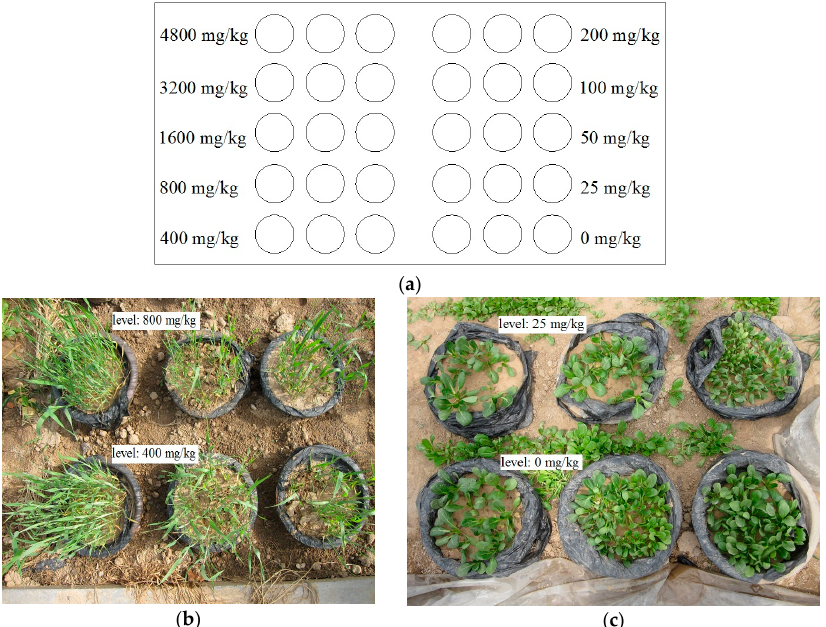
Figure 1. The experimental scene of some samples: ( a ) The distribution of plastic pots of wheat. (The pots distribution of pak choi is same with that of wheat. Circle: a pot); ( b ) Some samples of wheat (stress level: 400 mg/kg; 800 mg/kg); ( c ) Some samples of pak choi (stress level: 0 mg/kg; 25